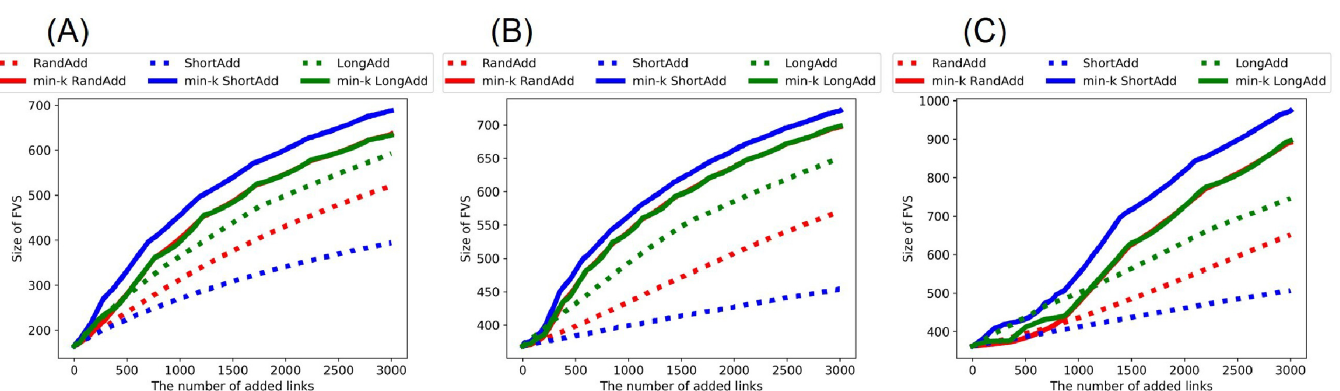
Fig 11. Size of FVS after adding links to real networks. In each figure of(A)(B)(C), the min- k ShortAdd method (a blue line) outperforms the other methods. The min- k RandAdd and min- k LongAdd methods (red and green solid lines) are also effective for increasing the size of FVS. The initial networks are (A) AirTraffic, (B) Email, and (C) Yeast. The correspondence between lines and methods is the same as shown in Fig 2.